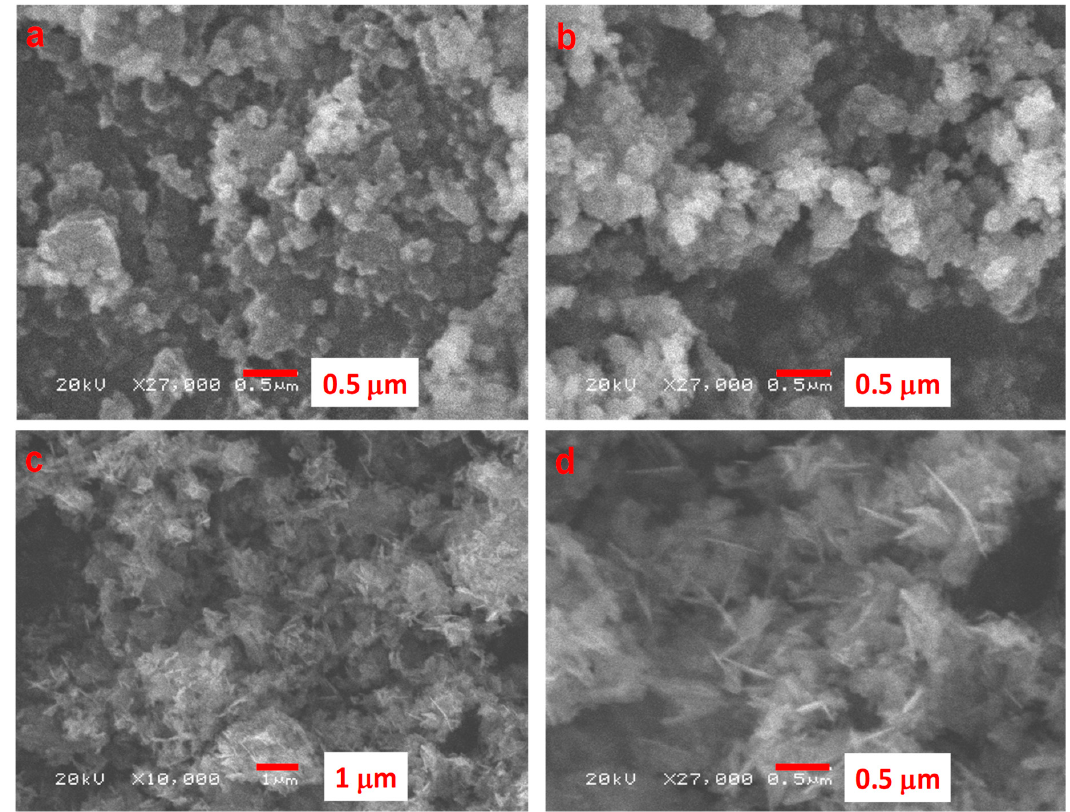
Figure 1. ( a ), ( b ) SEM images of ZnO nanoparticles prepared.by procedure (a); ( c ), ( d ) SEM images of Figure 1. ( a , b ) SEM images of ZnO nanoparticles prepared.by procedure (a); ( c , d ) SEM images of